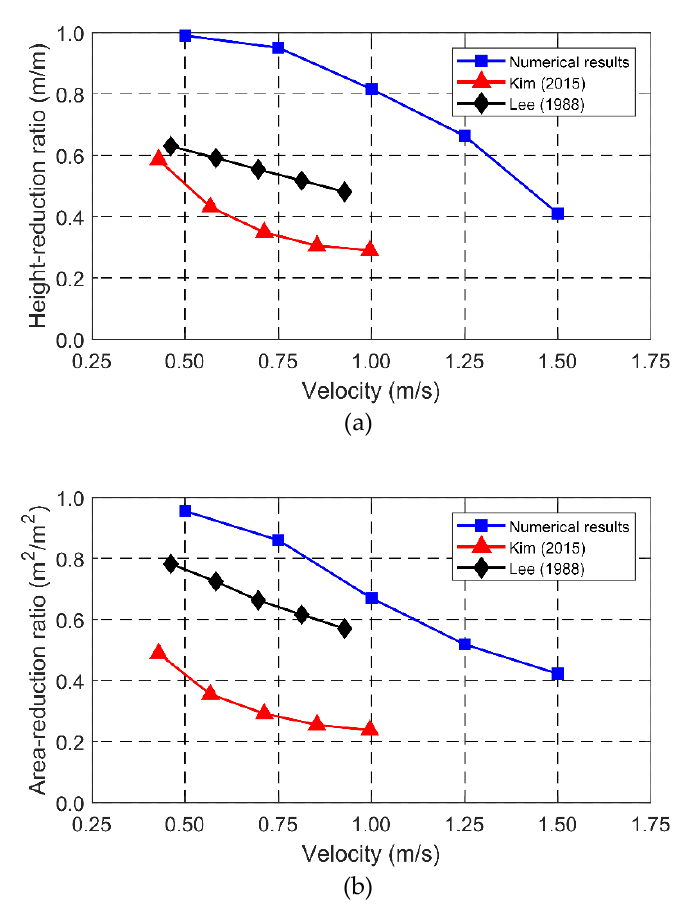
Figure 4. Height ( a )- and area ( b )-reduction ratios at different current velocities without wave excitations for